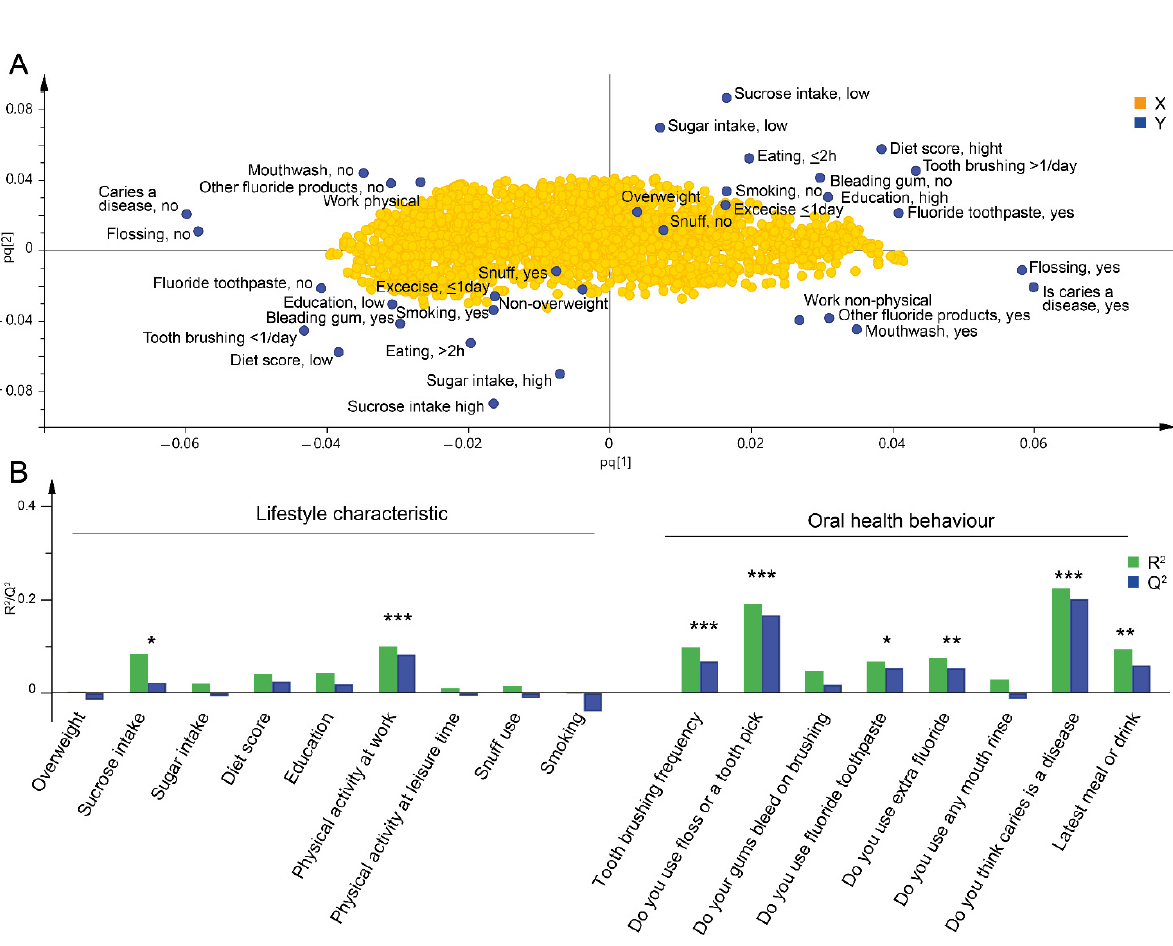
Figure 4. Predicted microbiota functions related to lifestyle characteristics and oral health behaviours. Orthogonal partial least square regression analysis was used to evaluate the effect of participants’ ( n = 401) oral health behaviours and lifestyle characteristics ( n = 17 lifestyle traits) on the composition of the predicted microbiota functions ( n = 10,140). ( A ) Loading score plot of oral health behaviours and lifestyle characteristics as dependent-y variables and predicted microbiota functions as independent-x variables. The loading score plot illustrates the correlation between the y and x variables. ( B ) Bar plot showing R 2 -value (green bar, indicates the fraction of the original data explained by the model) and Q 2 -value (blue bar, indicates the fraction of the original data explained by the seven-fold cross-validation model). * indicates significant difference between the respondents’ answers and the indicated question (P CV-ANOVA * < 0.05, ** < 0.01, *** < 0.001).